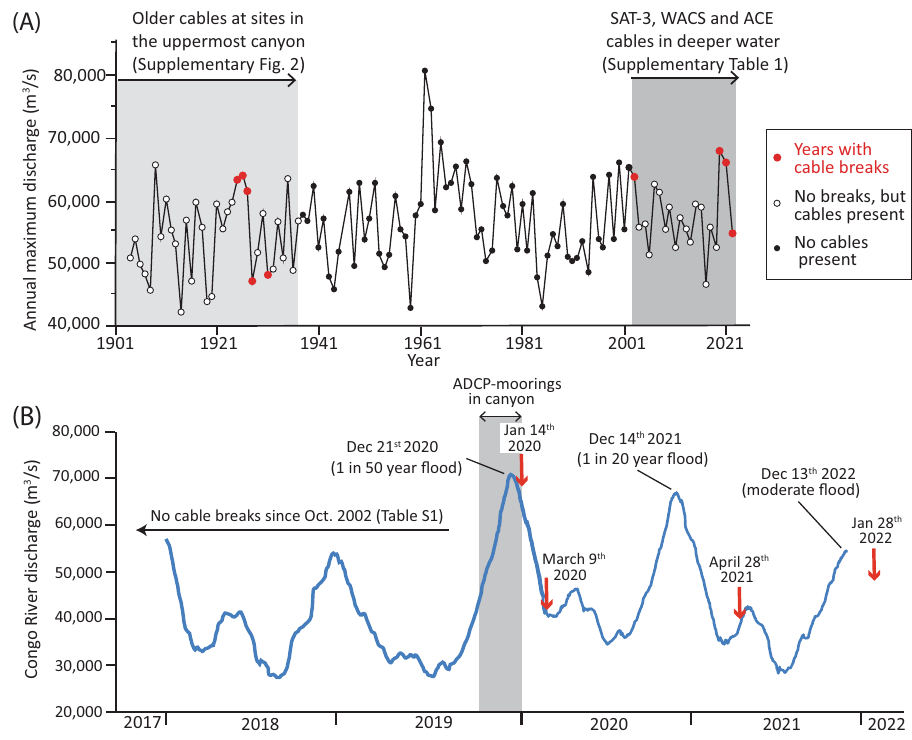
Fig. 3 Turbidity currents that break cables are associated with major fl oods along the Congo River. A Time series of annual maximum discharge of the Congo River, measured at Kinshasa. A river discharge of 70,883 m 3 /s occurred on December 21st 2019 that represents a 1-in-50 year fl ood, while a discharge of 67,210 m 3 /s occurred on December 12th 2020 that represent a 1-in-20 year fl ood. The SAT-3 submarine telecommunication cable had been in operation since 2001, and the last cable break before January 14th 2020 due to a turbidity current was in October 2001. B Daily Congo River discharge at Kinshasa from January 2018 to March 2020, showing timing of cable-breaking fl ows on 14th January and 9th March 2020, 28th April 2021, and January 28th 2022. There are delays of 3 weeks to 4.5 months between fl ood peaks and cable-breaking turbidity currents. The grey box shows when ADCP- moorings were deployed in the Congo Canyon during this project (Fig.